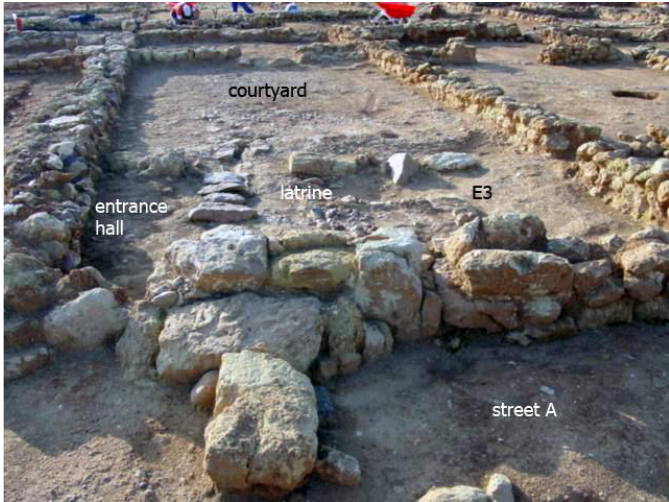
Figure 3. House 11. Plan and room distribution.